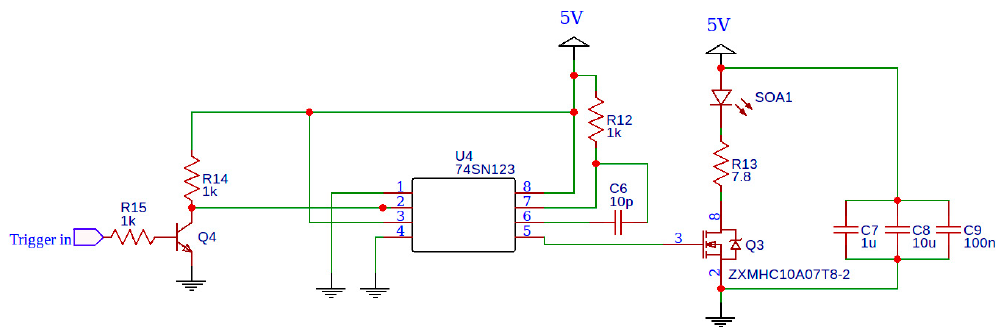
Figure 4. Trigger management, timer and pulse board. The 74SN123 timer is used to generate non-repetitive pulses triggered on the rising edge of a triggering signal coming from the ASG. We precisely select the pulse duration by the RC constant ( R 12 , C 6 ). The high-speed transistor Q 3 ensures rise / fall times below 2 ns. The condenser bank ( C 7 , C 8 , C 9 ) is an energy storage which combines three condensers to achieve both high capacity and fast response, to stabilize the power supply and short the irradiated interferences. Q 4 , a fast transistor, is a logical inverter introduced to adapt the square trigger signal from the voltage range − 2 to + 2 V to the range 0 to 5 V. Since Q 4 is an inverter, the ADC digitizer is set to trigger the measurement on the falling edge of the trigger signal provided by the ASG.